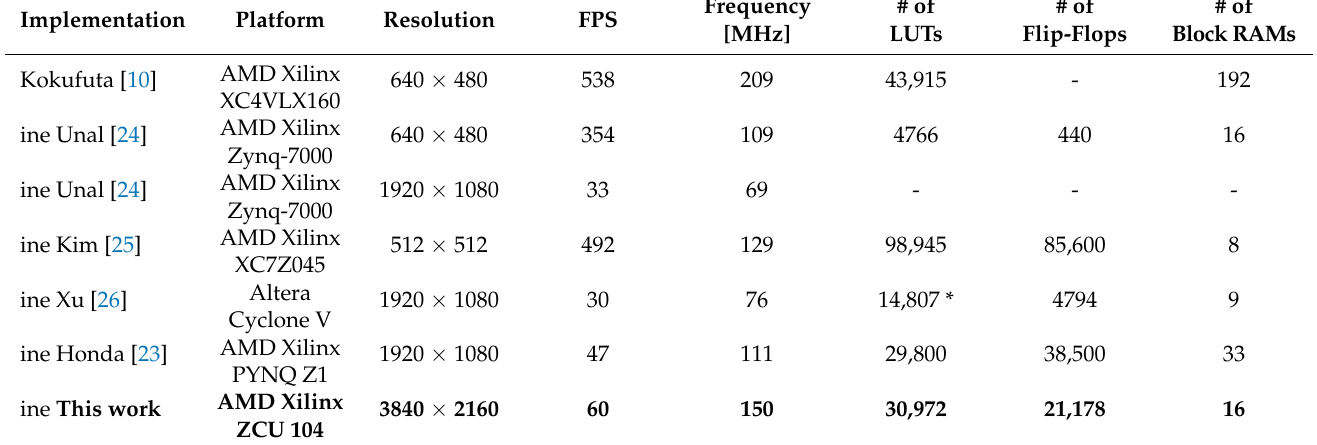
Table 1. Comparison of the most important parameters of hardware implementations of the CLAHE algorithm on FPGA platforms and resource utilisation for the CLAHE module. Only our solution